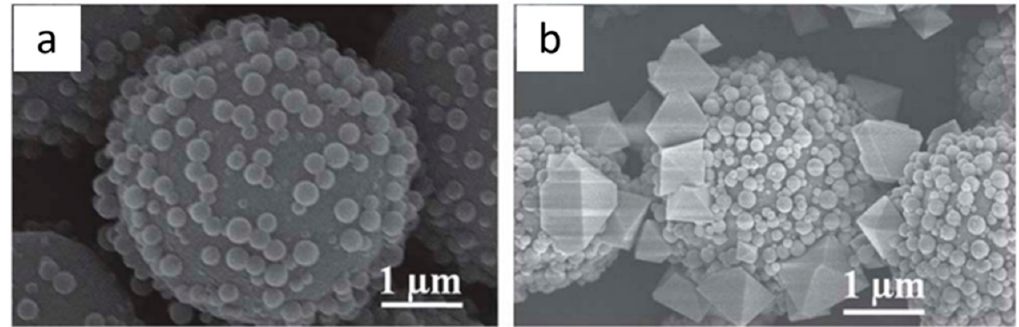
Figure 6. SEM images of ( a ) as-prepared spheres-on-sphere (SOS) silica particles particles and ( b ) HKUST-1@SOS-SiO 2 particles. Reproduced from [103], with permission from the Royal Society of Chemistry,